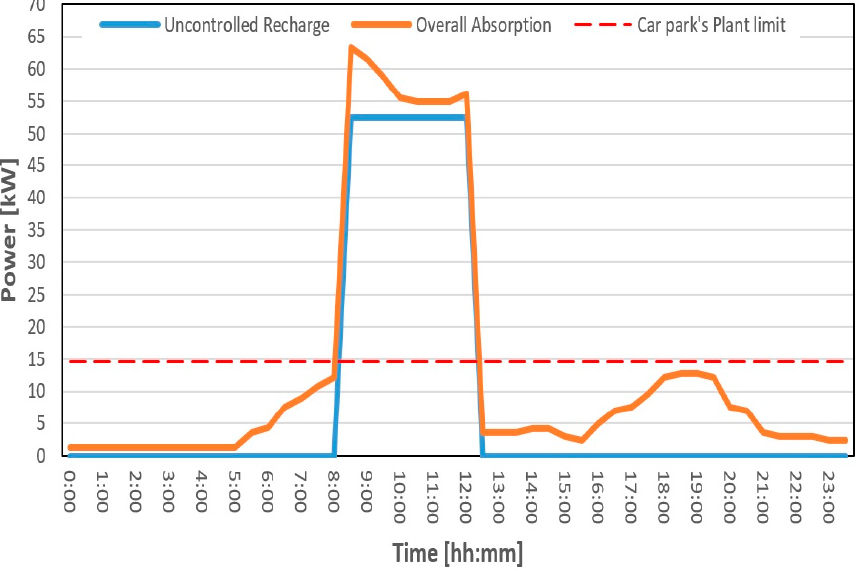
Figure 7. Example of uncontrolled charging of the five EVs implemented in the car park.